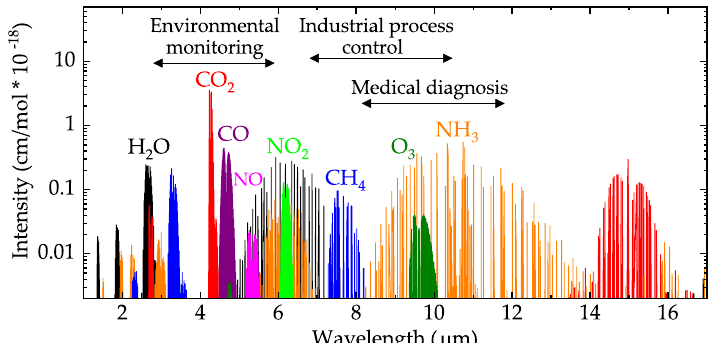
Figure 1. Mid-infrared absorption spectra of selected molecules with their relative intensities. H 2 O: water; CO 2 : carbon dioxide; CO: carbon monoxide; NO: nitric oxide; NO 2 ; nitrogen dioxide; CH 4 : methane; O 3 : oxygen; NH 3 : ammonia. Source: HITRAN [10]. Sensors 2019 , 19 , 2076;